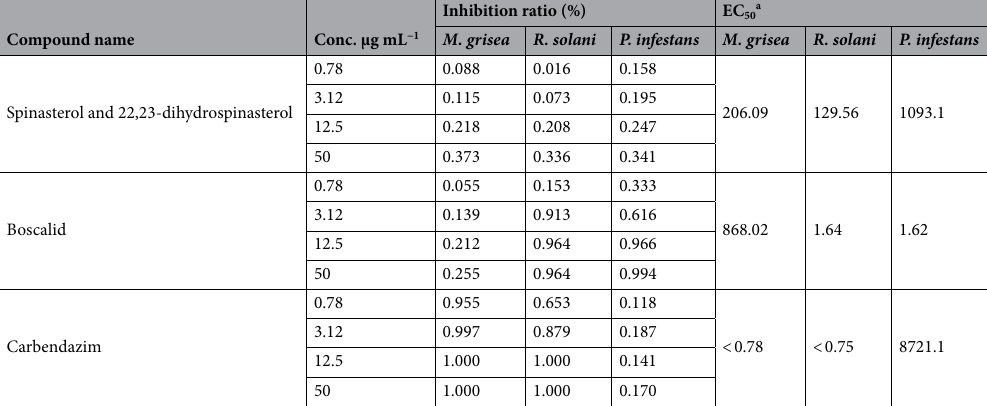
Table 2. Antifungal activity of spinasterol and 22,23-dihydrospinasterol against Magnaporthe grisea , Rhizoctonia solani , and Phytophthora infestans. a EC 50 , half maximal effective